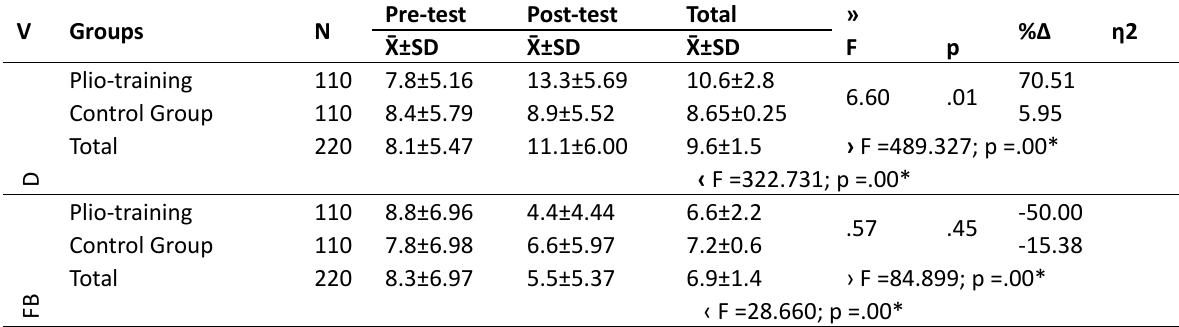
Table 6. Impact of plyometric training of the speed of the upper and lower extremities and endurance in force factors